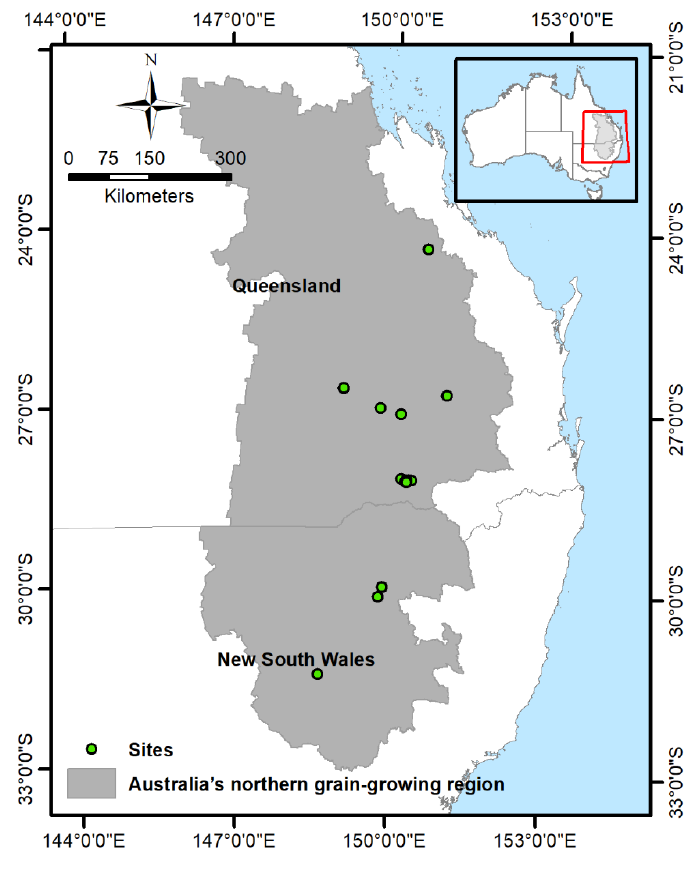
Figure 1. Study area.